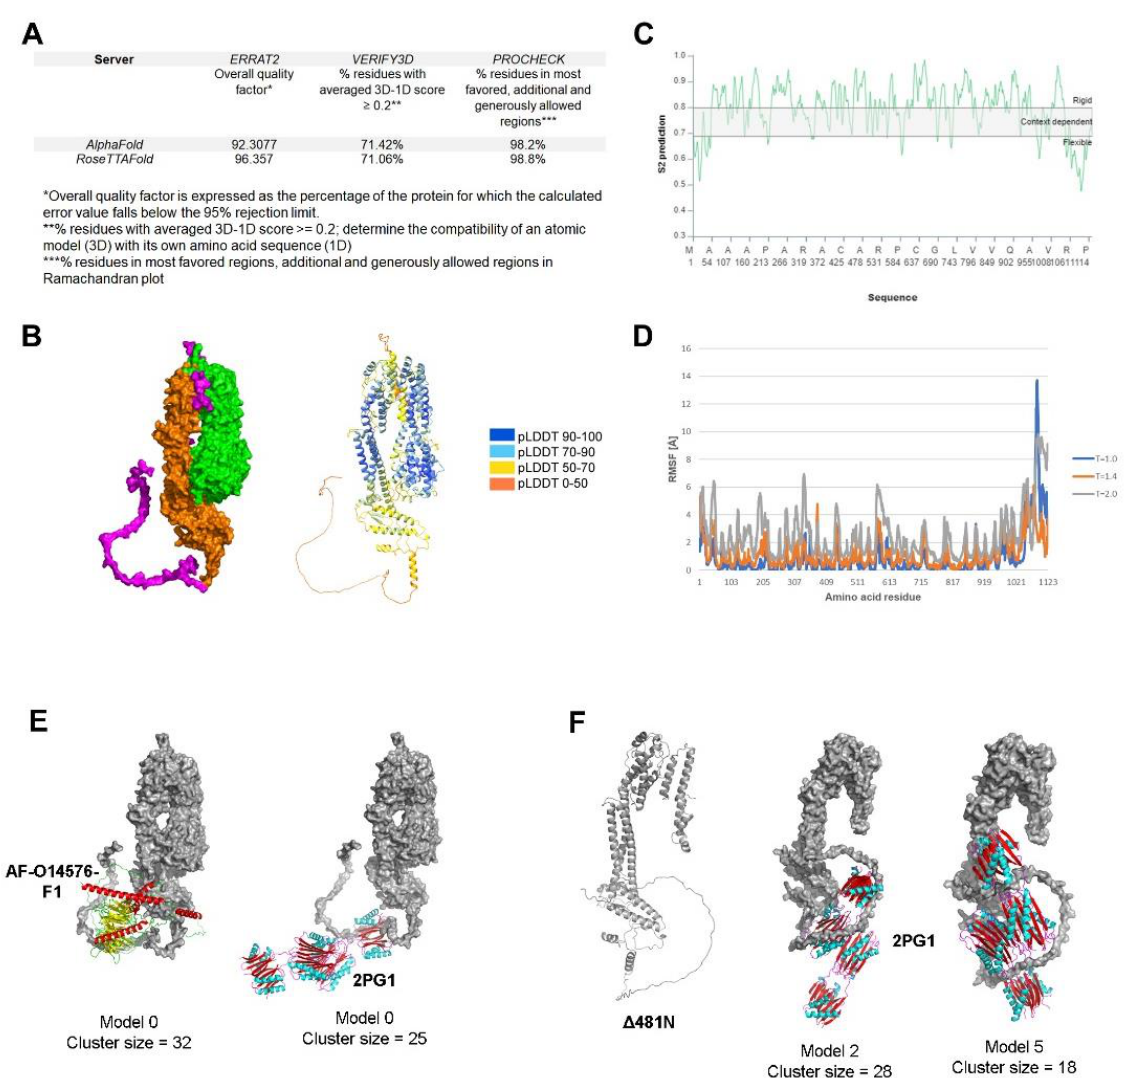
Figure 3. Predicted structure, flexibility and interaction analysis of HSV-1 UL37 . ( A ). Evaluation of predicted models generated by RoseTTAFold and AlphaFold. ERRAT2, Verify3D and PROCHECK